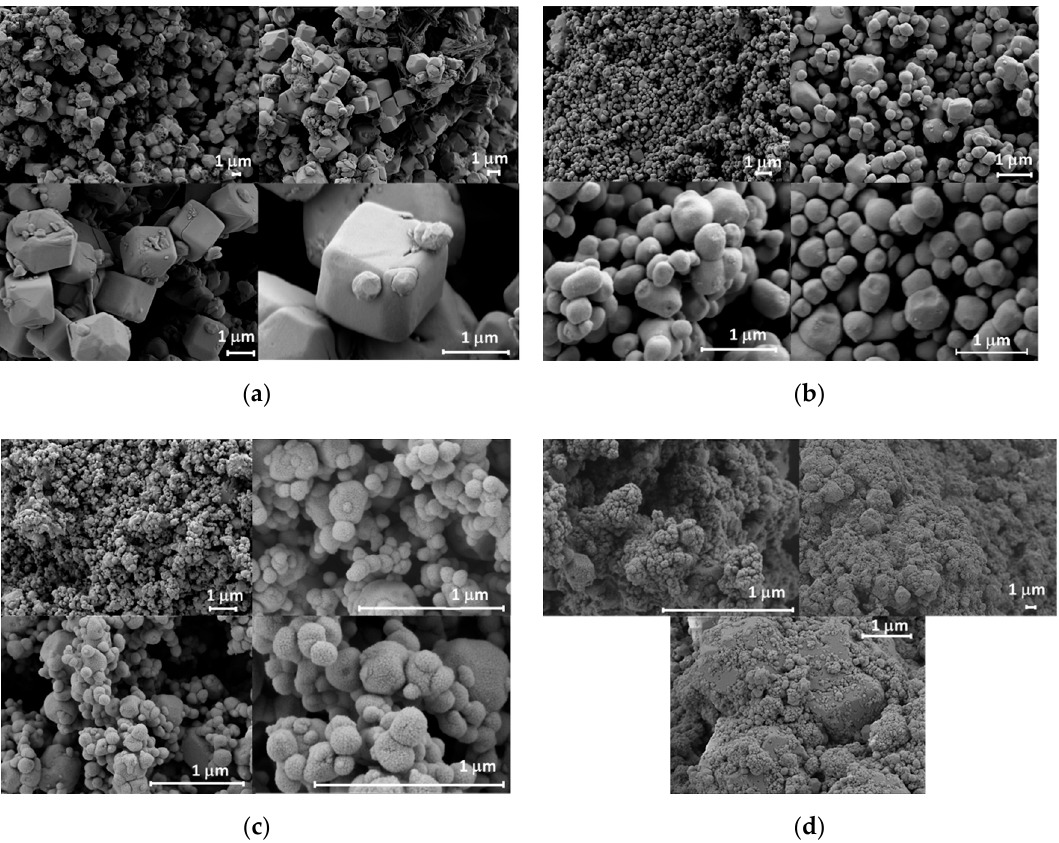
Figure 2. SEM Images of the synthesized photocatalysts: ( a ) Cubic Ag 3 PO 4 , ( b ) rhombic dodecahedron Ag 3 PO 4 , ( c ) spherical Ag 3 PO 4 , and ( d ) hybrid Ag 3 PO 4 –TiO 2 .